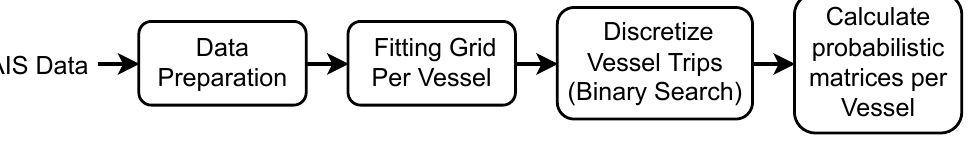
Figure 3. Training pipeline.